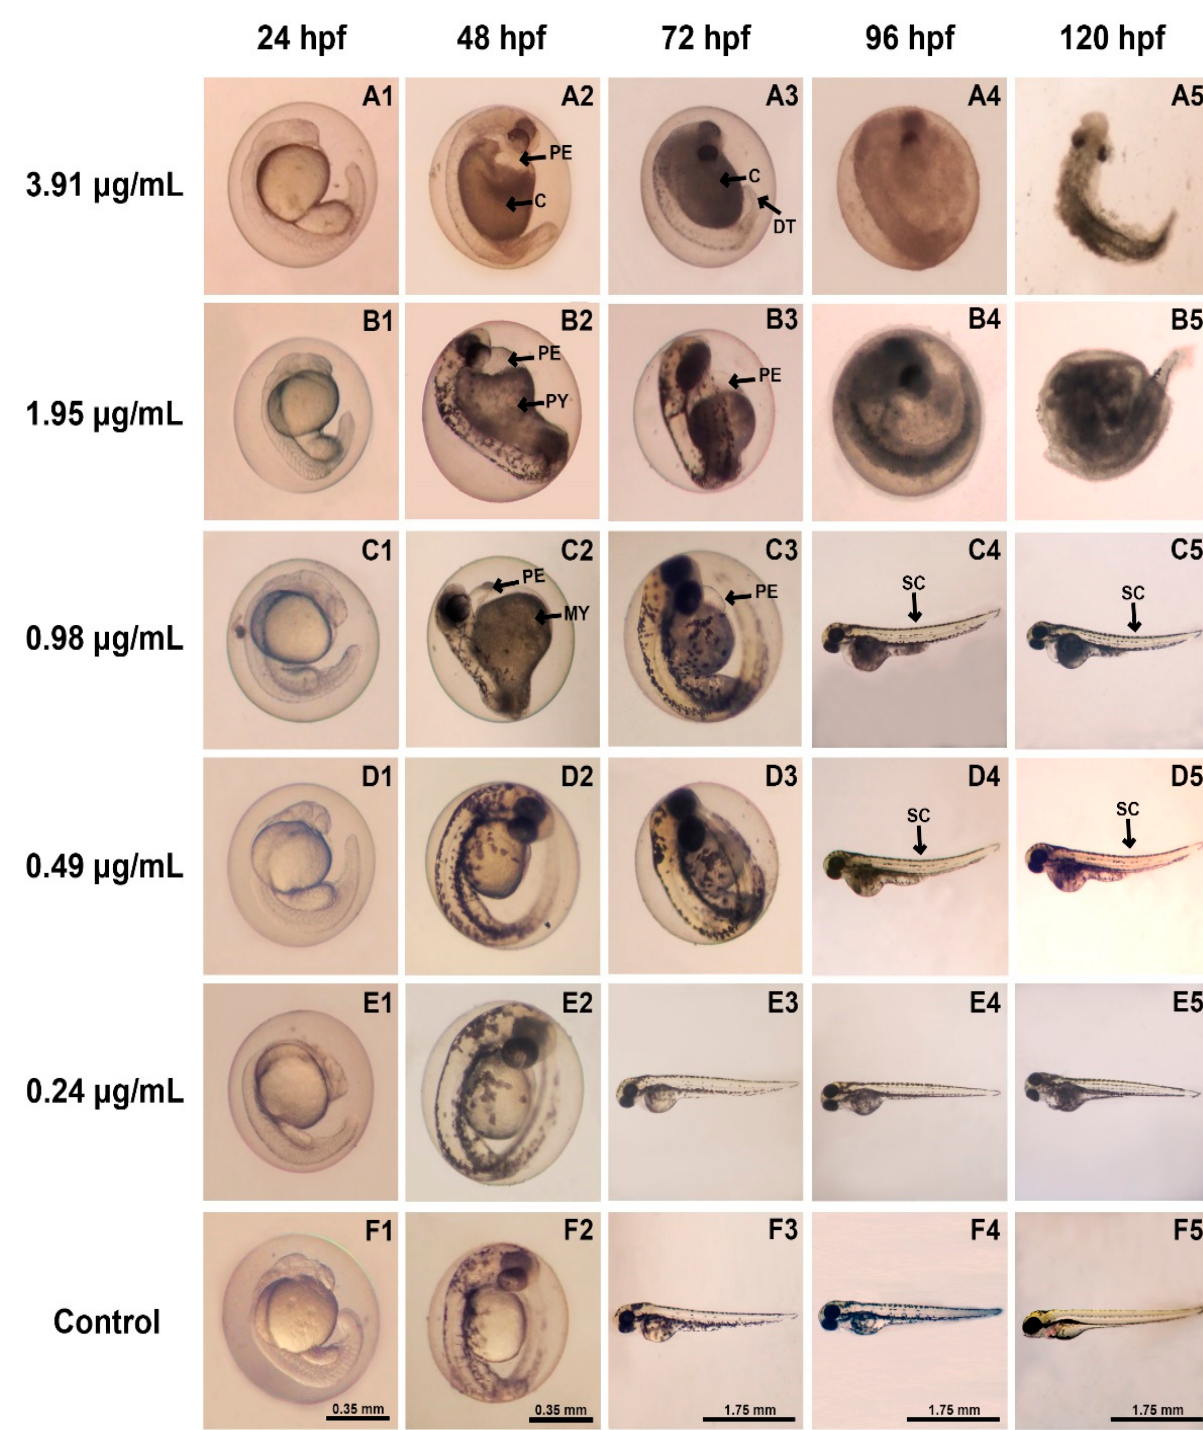
Figure 4. Morphological characteristics of zebrafish embryos and larvae treated with different concentrations of ZO essential oil or vehicle at different time points (24–120 hpf). Normal morphology was found in the group treated with the lowest concentrations and with vehicle ( E , F ). Typical malformations of zebrafish development were observed in embryos that had received ZO essential oil at a dose of 0.49–3.91 µg/mL ( A – D ). Abbreviations: PE, pericardial sac edema; C, coagulation; DT, dented tail; PY, poor reabsorption of yolk sac; MY, malformation of yolk sac; SC, spinal curvature.